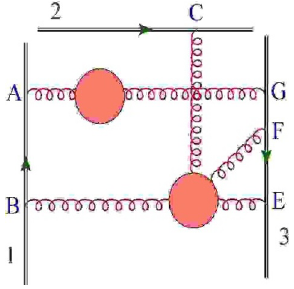
Figure 8. Skeleton diagram C 1 for the Cweb W (1 , 0 , 1)